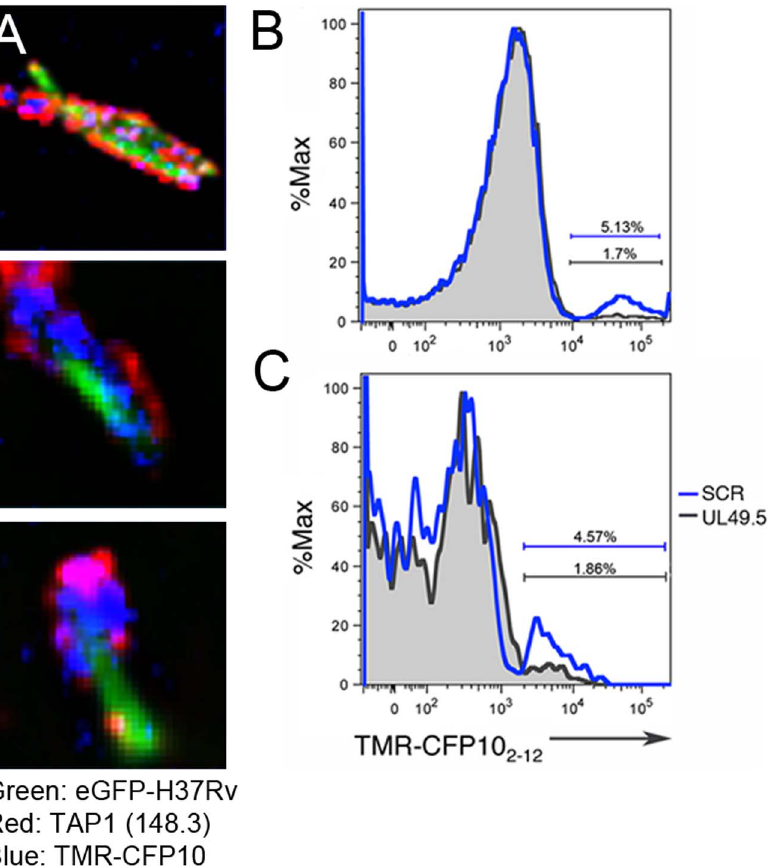
Figure 3. Phagosomal TAP transports peptides into the lumen. A) Isolated GFP-Mtb-phagosomes were incubated with TMR-conjugated CFP10 2–12 peptide (blue), then fixed and stained with anti-TAP1 (red) and analyzed by fluorescence microscopy. B) TMR-conjugated CFP10 2–12 peptide (500 nM) and UL49.5-NP (10 uM) or UL49.5-SCR (10 uM) were added simultaneously to isolated Mtb phagosomes and incubated at 37 u C for 30 min. Washed and fixed phagosomes were analyzed by FACS. FACS plot is representative of three independent experiments. C) Prior to infection, Mtb was coupled to UL49.5-NP or UL49.5-SCR to target the inhibitor specifically to the Mtb phagosome. Isolated phagosomes were then incubated with TMR-conjugated CFP10 2–12 peptide as indicated above. FACS plot is representative of two independent experiments.